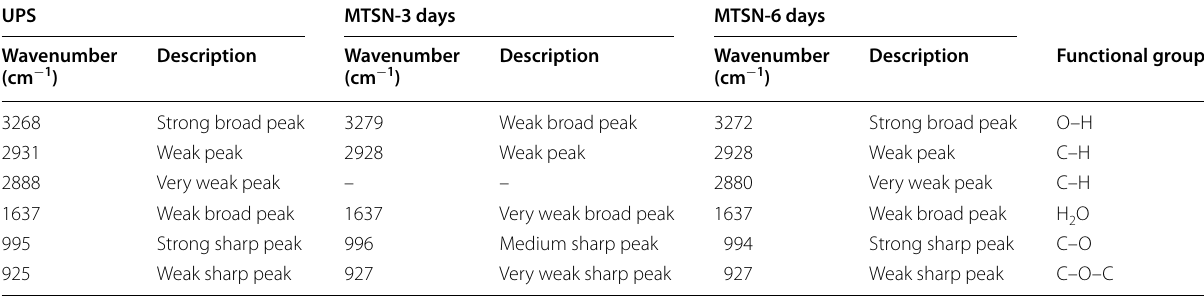
Table 6 Table of untreated potato starch (UPS) and mechanically treated starch nanoparticles (MTSN) wavenumbers depicted in FTIR analysis with corresponding functional